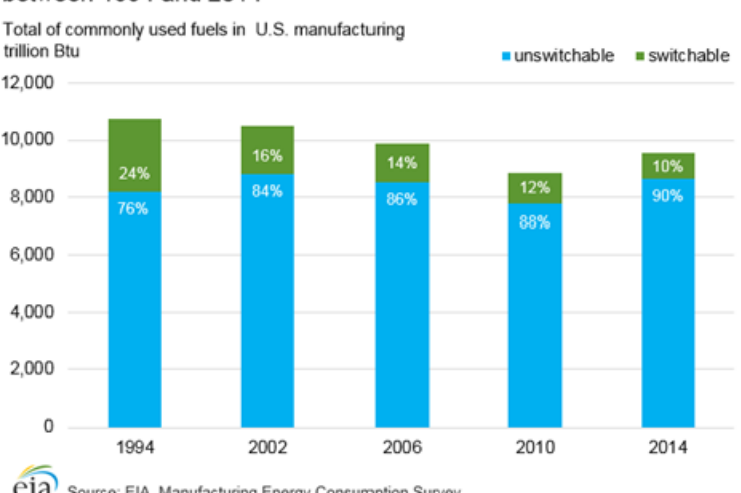
Figure 2. Manufacturing fuel source flexibility. Source: US Department of Energy, Energy Information Administration [94].